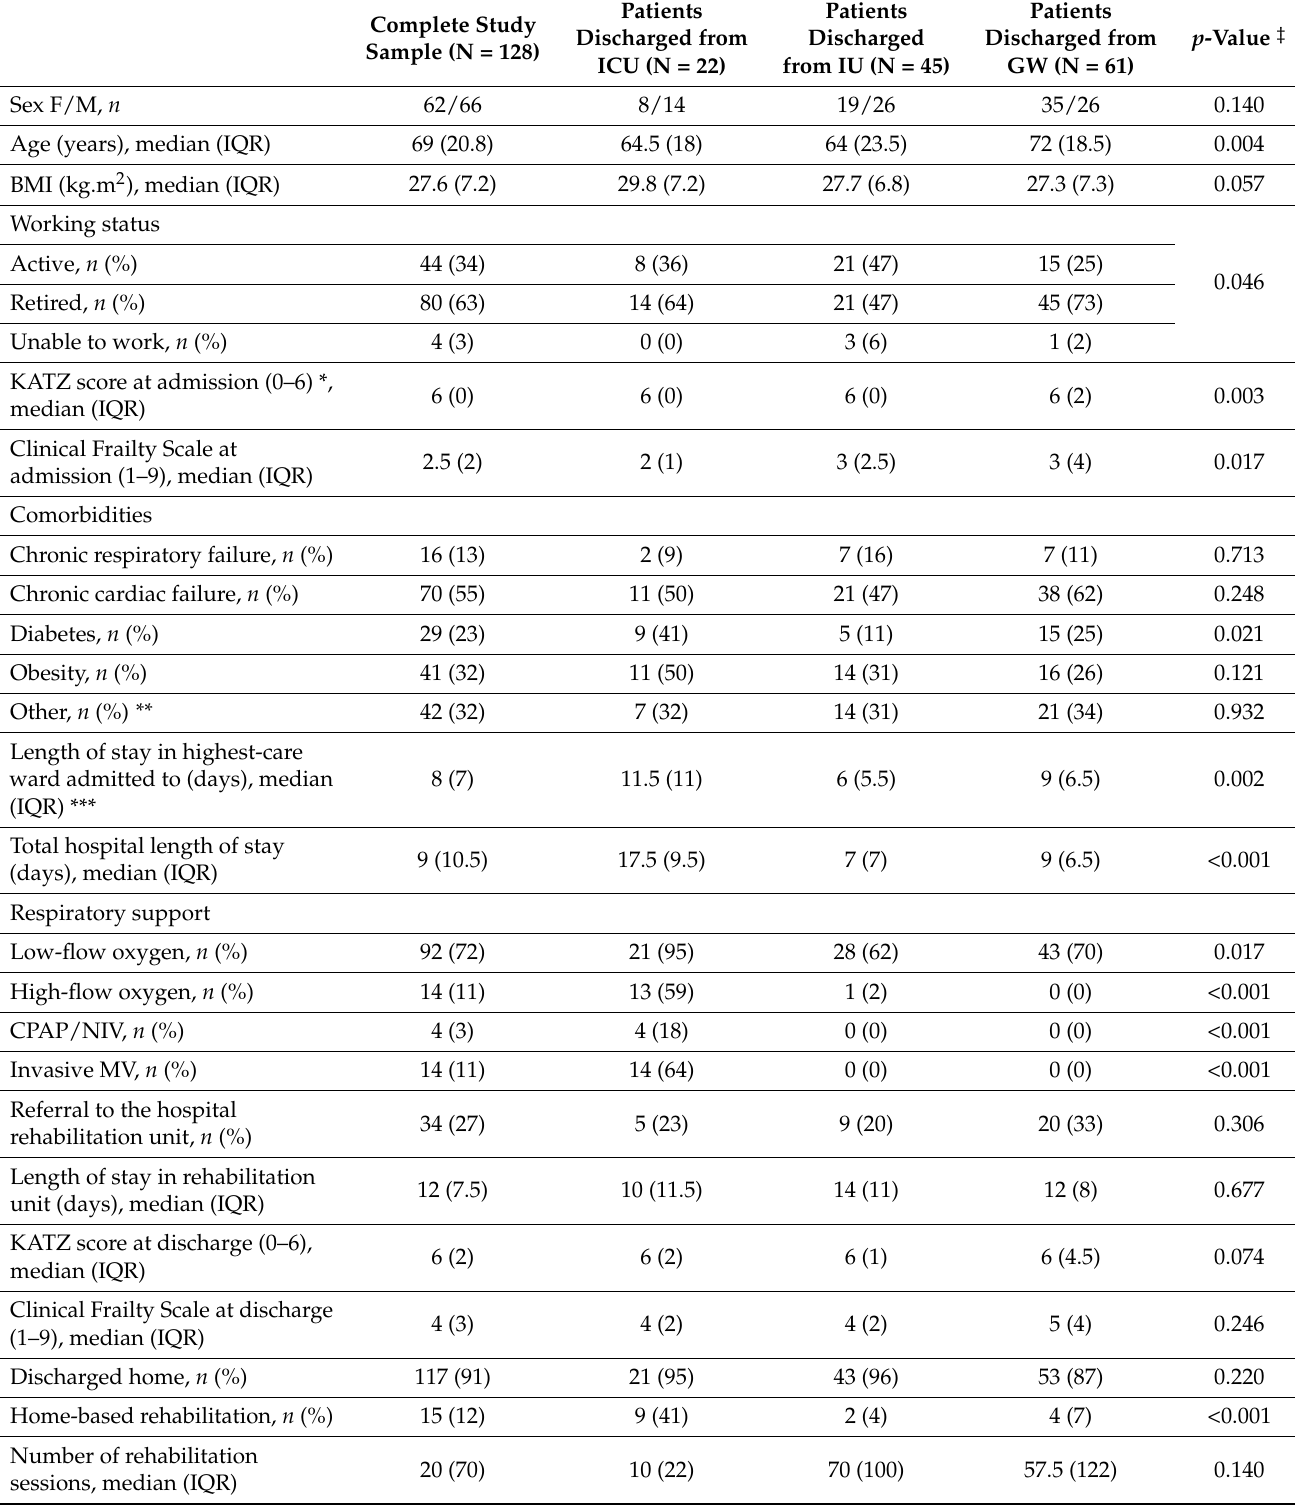
Table 1. Patient characteristics, details of hospital stay, and treatment on admission, during hospital- ization, and at